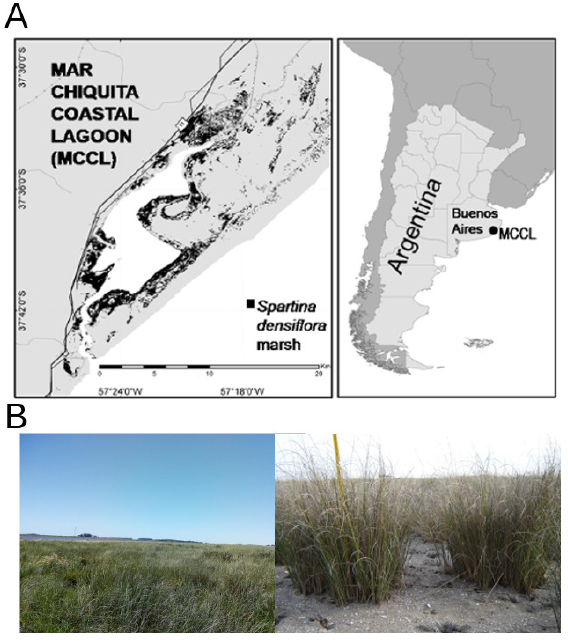
Figure 1. Location of the site of study (A) and pictures of the dominant vegetation Sporobolus densiflorus